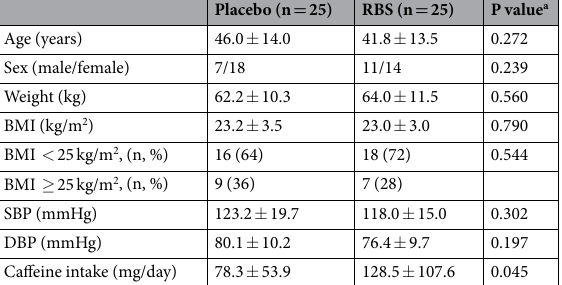
Table 1. Baseline characteristics of the study participants. Data are expressed as the mean ± standard deviation or number. a Independent t-tests or Chi-squared tests were used to determine significant differences between the groups. DBP: diastolic blood pressure; SBP: systolic blood pressure.